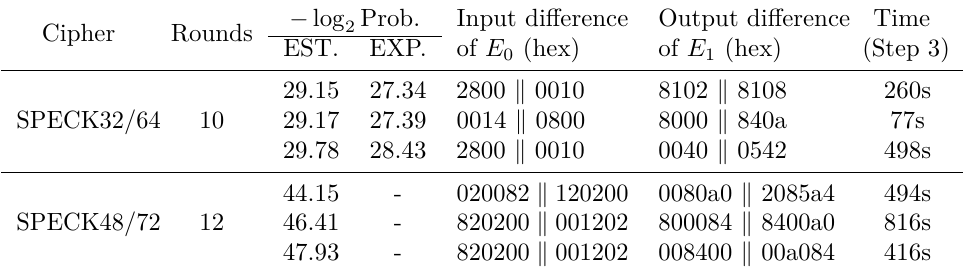
Table 4: Boomerang distinguishers on